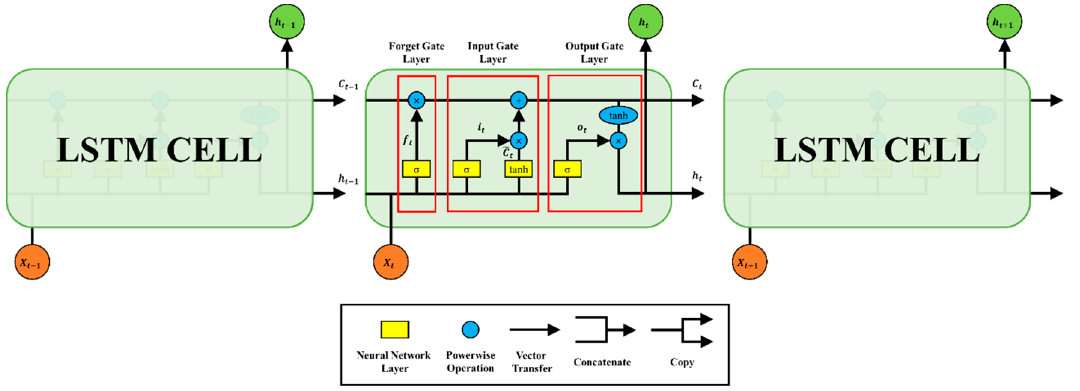
Figure 3. Basic LSTM Architecture.